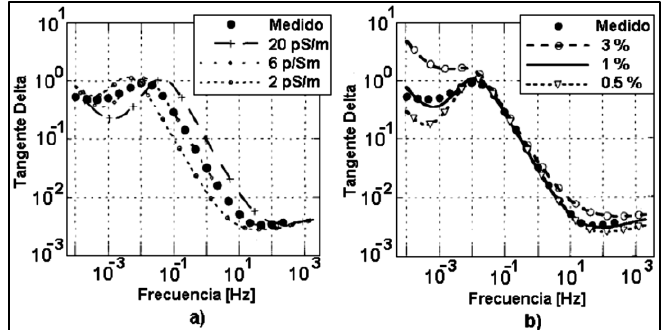
Figura 17: a) curva de tan δ delta para 3 conductividades del aceite y b) curva para 3 contenidos de humedad del